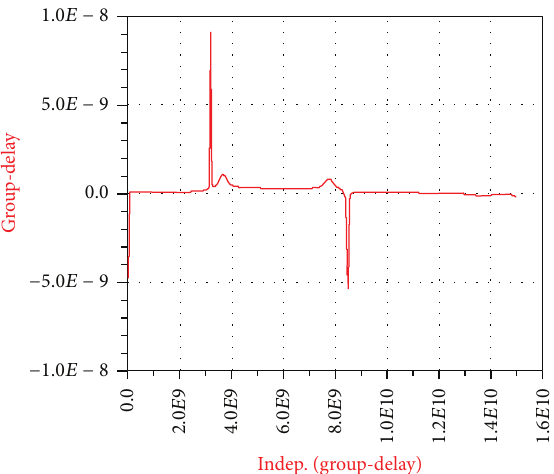
Figure 10: Group-delay of the broadband band-pass filter designed using a MMR resonator.